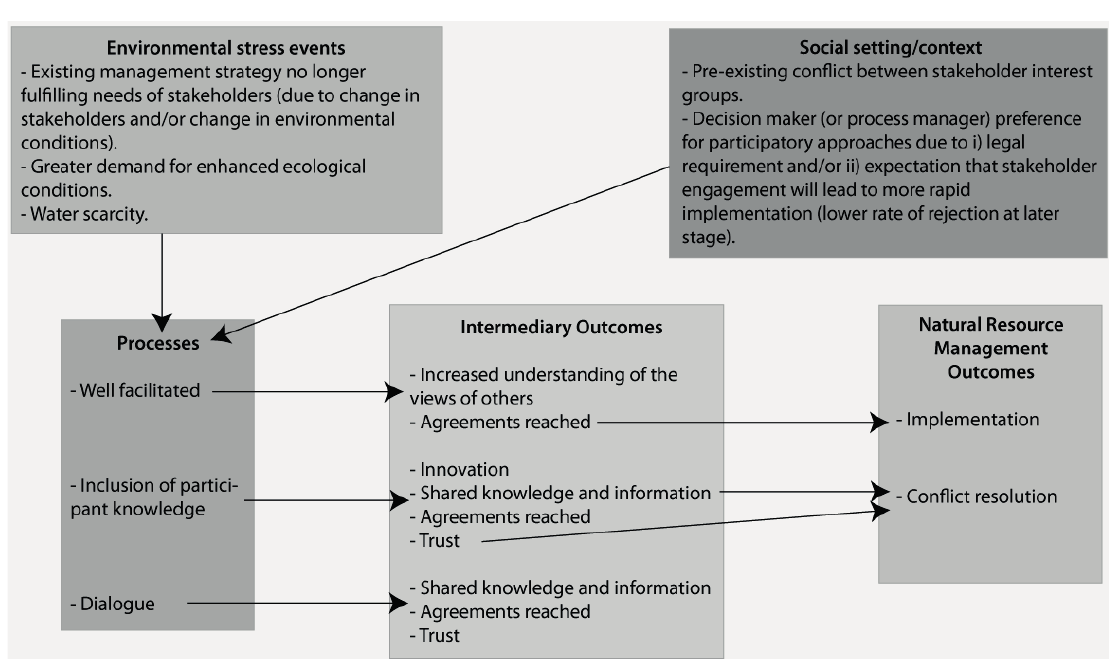
Fig. 2 Interactions between environmental stress events, context, process factors, intermediary outcomes and resource management outcomes based on Table 1. Only process and outcome relationships identified in more than two case studies are